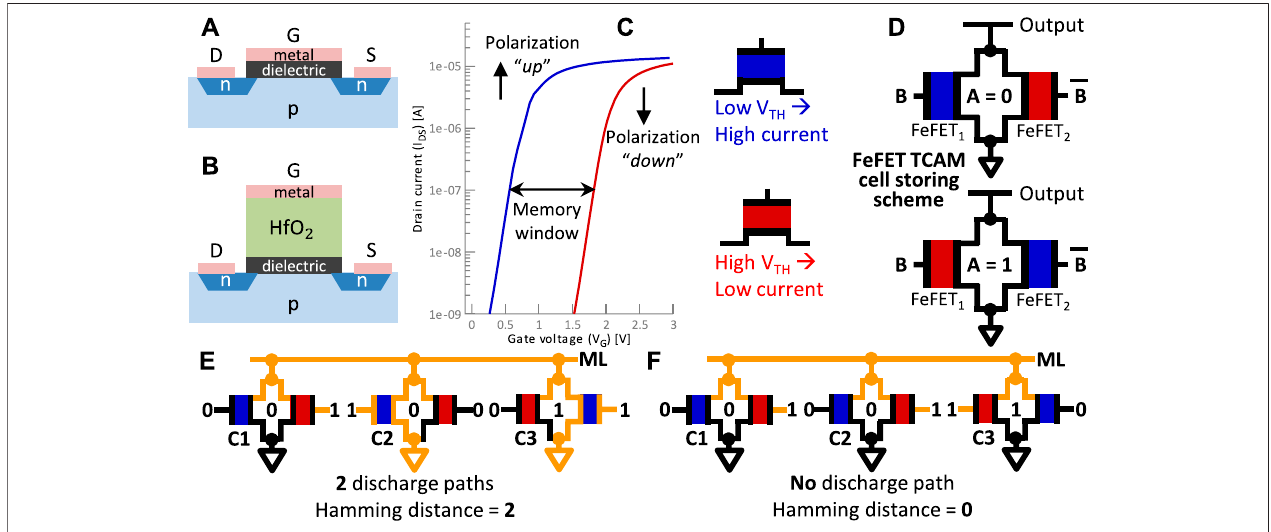
FIGURE 2 | (A) Sketch of planar transistor. (B) Sketch of FeFET with a thick HfO 2 layer (e.g., 10 nm). (C) I D - V G loop showing two distinguishable states (low − V TH and high − V TH ) due to the polarization of the FE layer in the transistor. (D) Single TCAM cell implemented with FeFET and the storing scheme. (E) TCAM block example withtwomismatches,formingtwodischargepaths(i.e.,Hammingdistance=2). (F) TCAMblockexamplewithnomismatches,whereforenoconductingpathisformed.